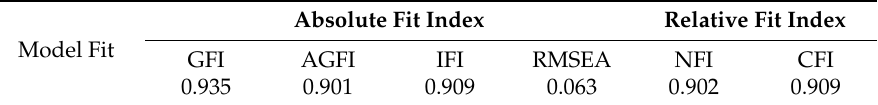
Table 4. The model fit.